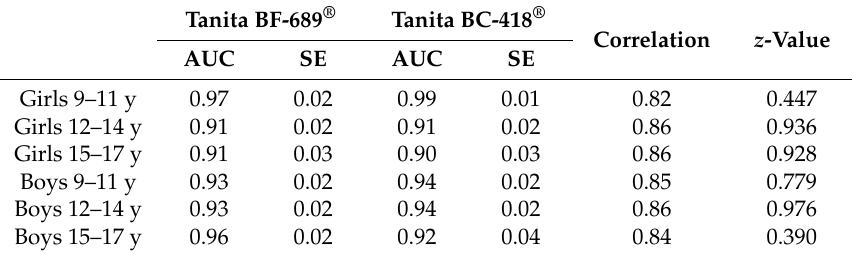
Figure 2. Adjusted odds ratios (OR), with 95% confidence intervals, of being at increased cardiometabolic risk with BF% above and below sex ‐ and age ‐ specific thresholds and BMI (<2SD or ≥ 2SD). Table 4. Differences between areas under the receiver-operating for each BIA